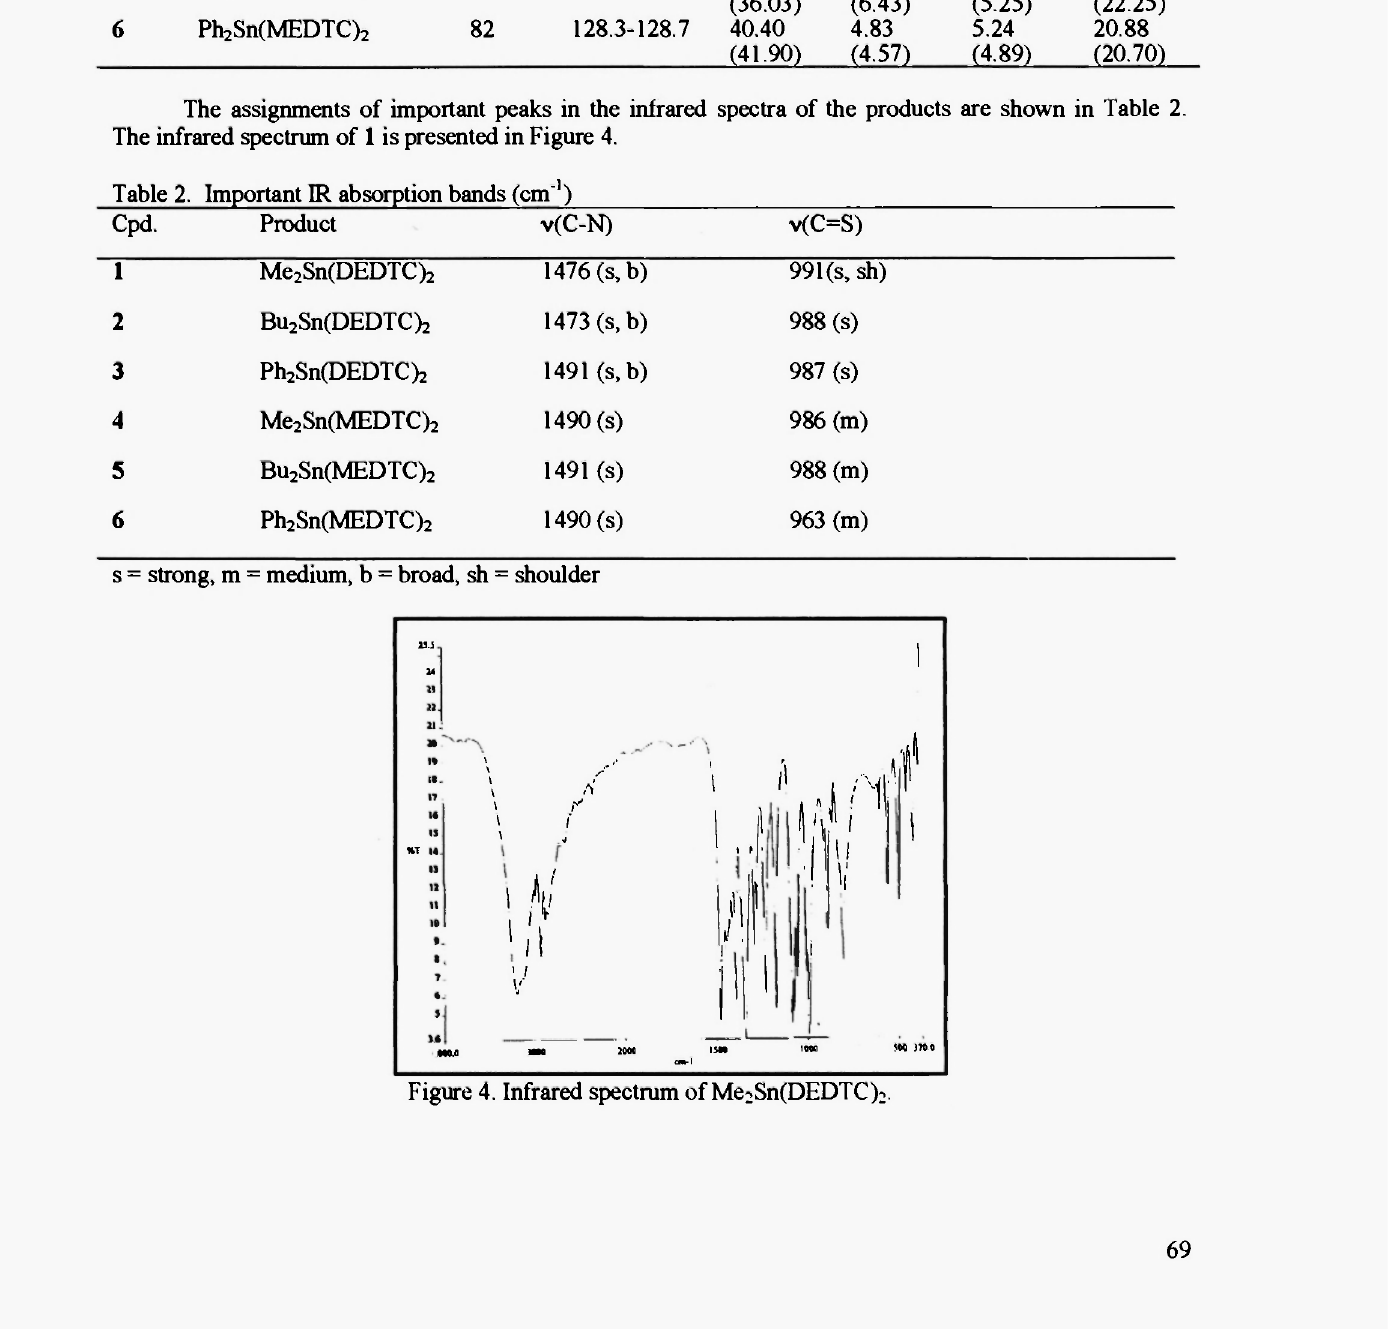
Table 1. Percentage yield, melting point and elemental analysis data. Cpd.